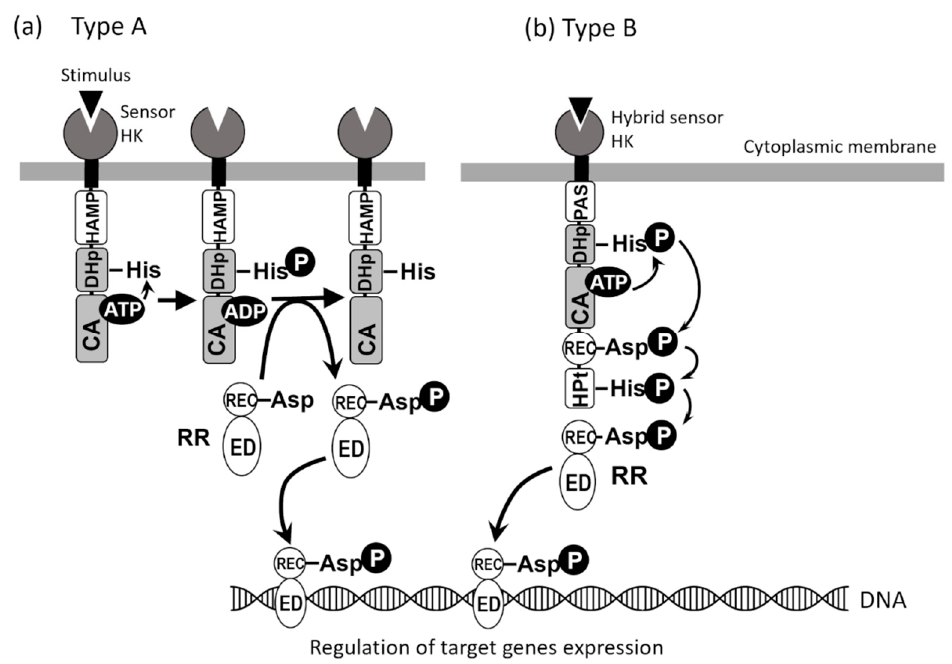
Figure 1. Schematic representation of the two types of TCSs. ( a ) In Type A, the sensor domain at the N-terminal region of HK is followed by HAMP (a domain found in Histidine kinases, Adenyl cyclases, Methyl-accepting proteins, and Phosphatases), DHp (Dimerization and Histidine phosphotransfer domain), and CA (Catalytic and ATP-binding domain) at the C-terminal region. ( b ) In Type B, the sensor domain at the N-terminal region of the hybrid sensor is followed by PAS (Per-Arnt-Sim domain), DHp, CA, REC (Receiver domain), and HPt (Histidine Phosphotransfer domain) at the C-terminal region. RR consists of the REC domain (N-terminal) and ED (Effector domain) (C-terminal).